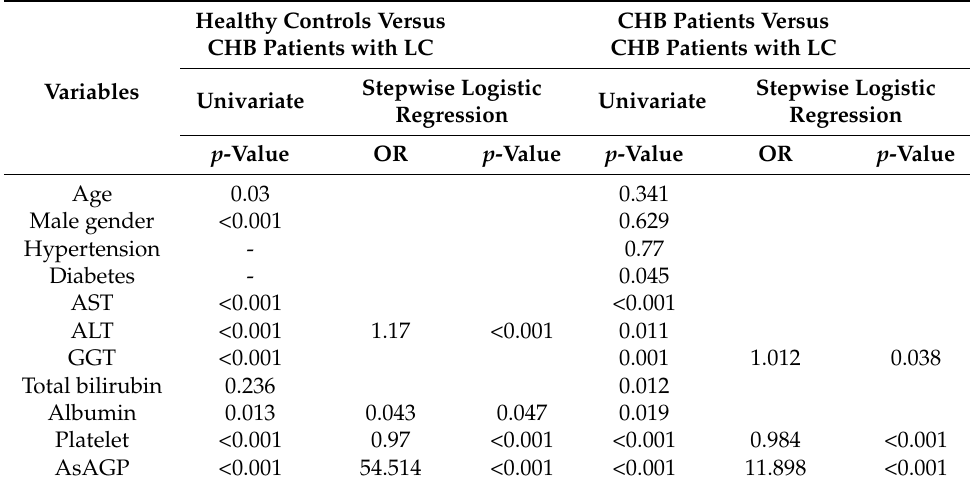
Table 6. Univariate and multivariate analyses of predictors for detecting CHB with